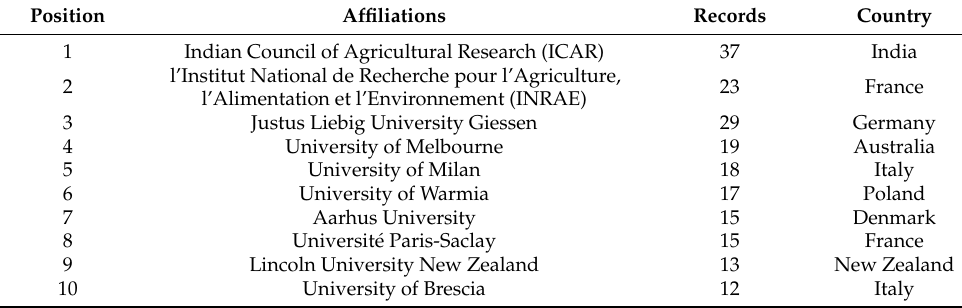
Table 1. Top 10 most productive affiliations in the A2 β -casein research